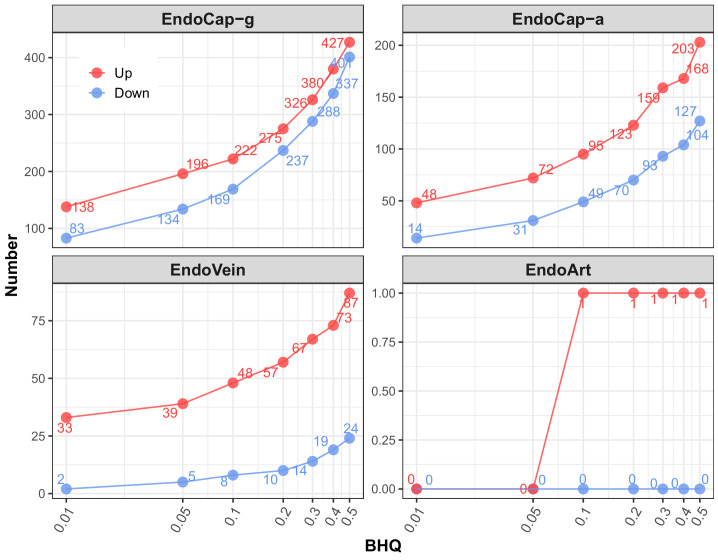
Number of differentially expressed IH-responsive genes in four lung endothelial subpopulations using BHQ cutoffs.At series BHQ cutoffs, the number of up- and downregulated genes in lung endothelial subpopulations as a response to IH are shown with red and blue lines, respectively. The four endothelial subpopulations include endothelial artery (EndoArt), vein (EndoVein), general capillary (EndoCap-g) cells, and capillary aerocytes (EndoCap-a).